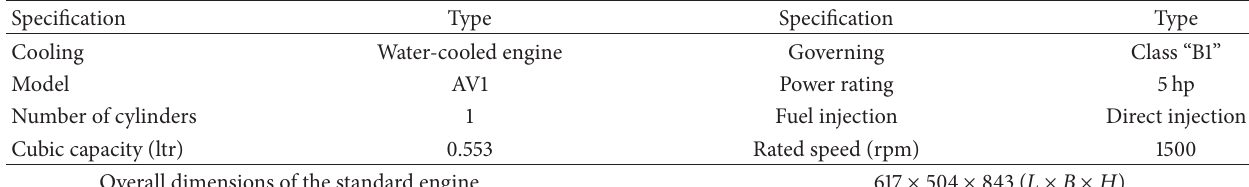
Table 1: Engines and their